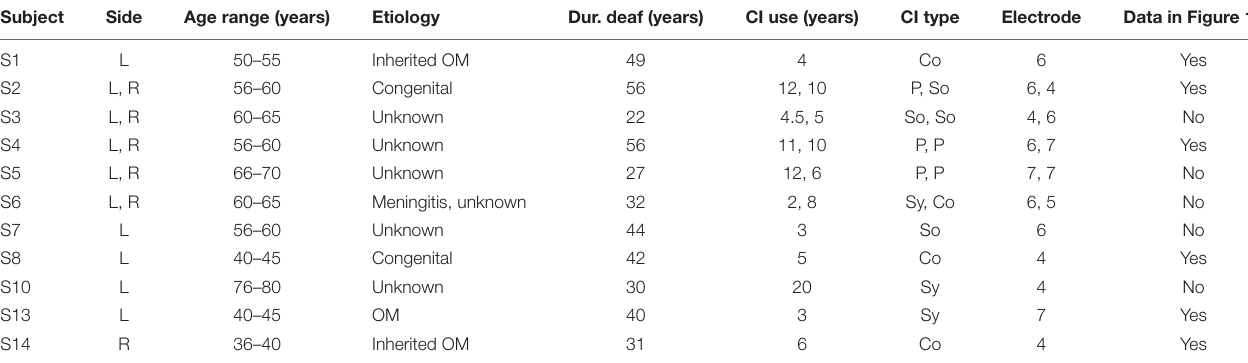
TABLE 1 | Demographic information of CI subjects that participated in the study.